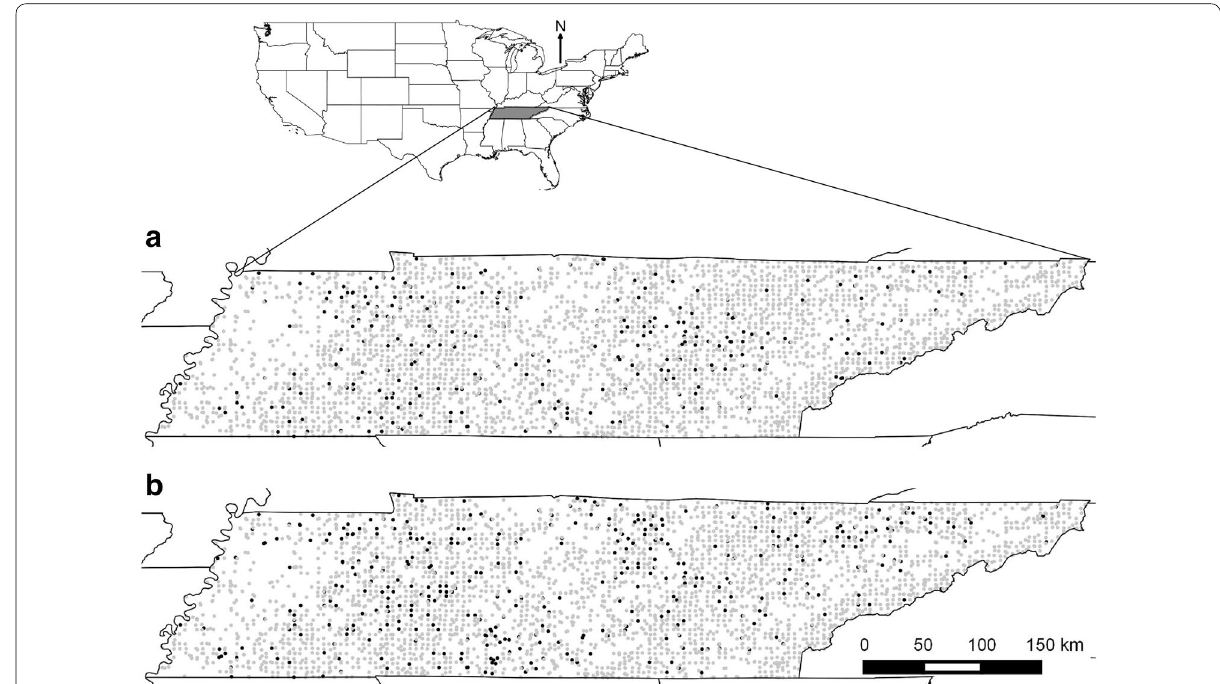
Fig. 1 Presence (black dots) and absence (gray dots) of Japanese stiltgrass in forested plots sampled in Tennessee in surveys conducted a 2000–2005 and b 2006–2011 as part of the Forest Inventory and Analysis Program of the U.S. Forest Service